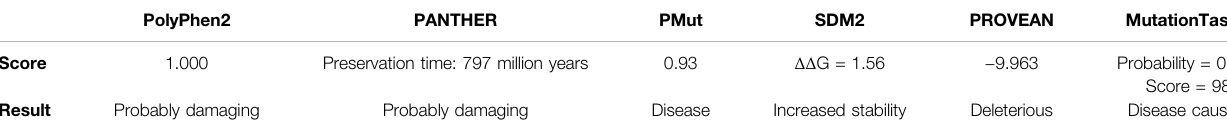
TABLE 2 | In silico predictions of functional effects for Cx50-P88L